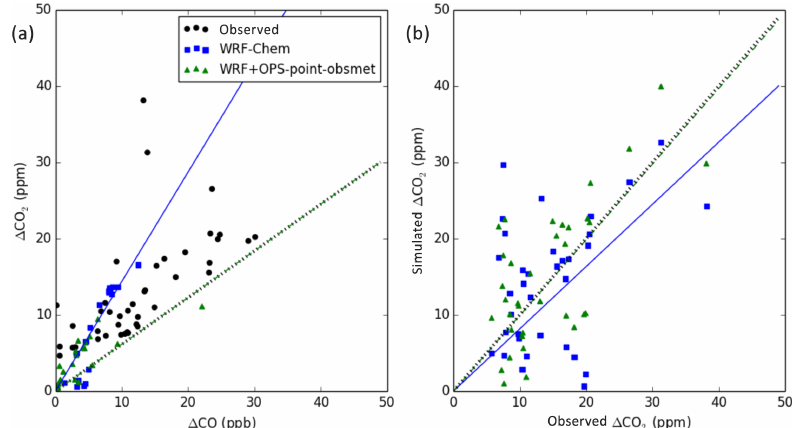
Figure A1. (a) A scatter plot of (cid:49) CO and (cid:49) CO 2 , where the slopes (represented by lines) represent the (cid:49) CO : (cid:49) CO 2 ratio for the observed and modelled values. The slope of WRF + OPS-point-obsmet coincides with the slope of the observations, suggesting good agreement. (b) A scatter plot of simulated (cid:49) CO 2 to observed (cid:49) CO 2 . The slope of WRF + OPS-point-obsmet coincides with the 1 : 1 line (dotted line), suggesting good agreement with the